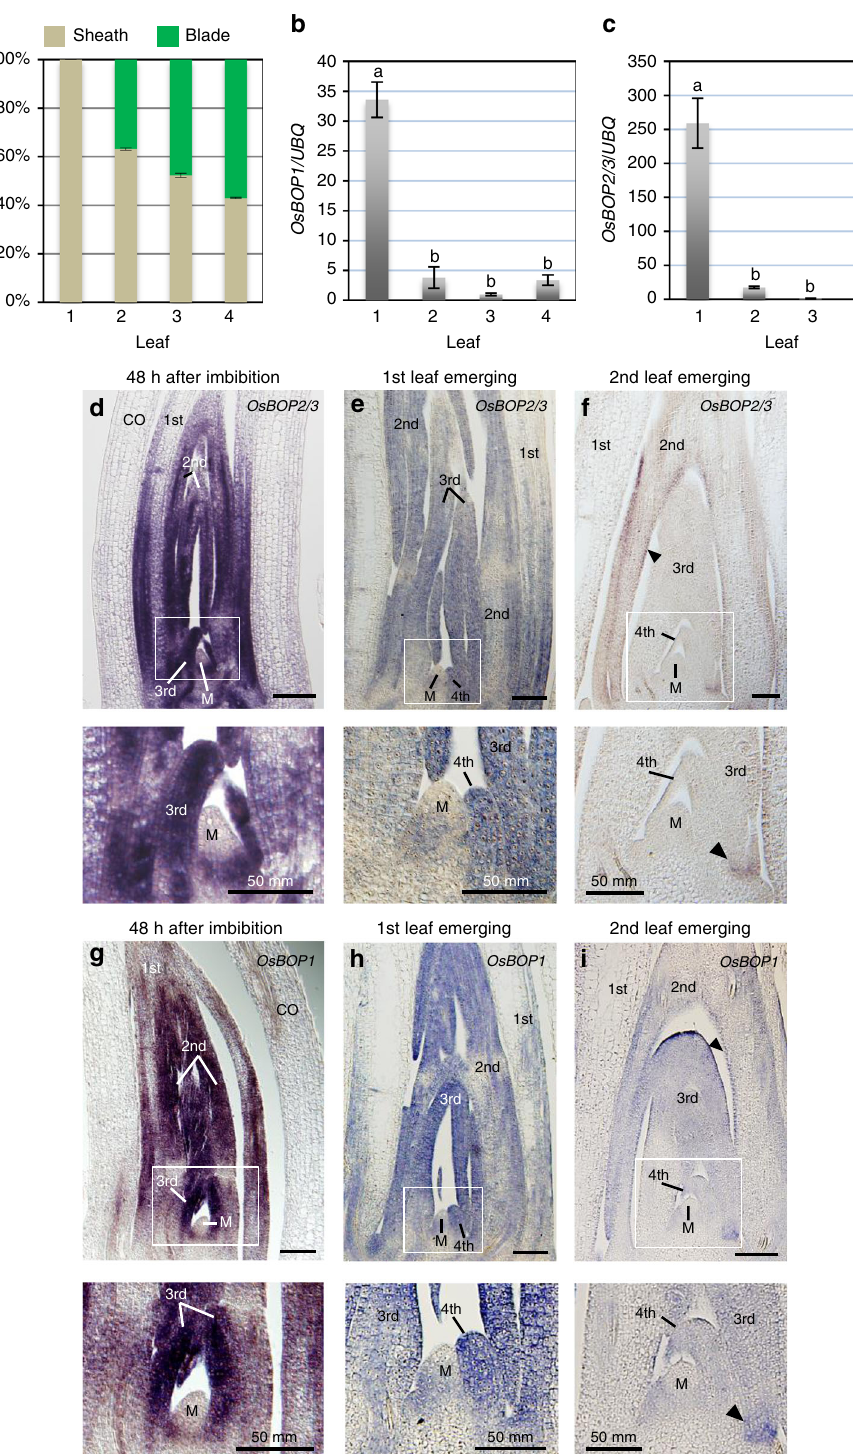
Fig. 4 Expression patterns of the OsBOP genes in juvenile leaves. a The proportion of leaf blade and sheath in the fi rst four leaves of WT. Error bars indicate standard error ( n = 3 biologically independent samples). b , c Relative expression levels of OsBOP1 ( b ) and OsBOP2/3 ( c ) in the fi rst four leaves. Each leaf was collected just as it was emerging from the coleoptile (the fi rst leaf) or from the sheath of the previous leaf (the second to fourth leaf). The relative expression value of the third leaf is shown as 1.0. Error bars indicate standard error ( n = 3 biologically independent samples). The fi rst leaf has signi fi cantly higher expression levels of OsBOP1 and OsBOP2/3 than the others (Tukey-Kramer test, P < 0.05). The signi fi cant difference is indicated by different signs on the graph. d – i Localization of OsBOP2/3 mRNA ( d – f ) and OsBOP1 mRNA ( g – i ) in germinating shoots 48 h after imbibition ( d , g ), at the emergence of the fi rst leaf ( e , h ) and at the emergence of the second leaf ( f , i ). A close-up view of the white squares in d – i is shown immediately below the panel. Arrowheads indicate the epidermis of the second leaf primordia. Arrowheads indicate lower part of the third leaf. CO, coleoptile; M, shoot apical meristem. Bars: 100 μ m ( d – i ). Source data of Fig. 4a – c are provided as a Source Data fi